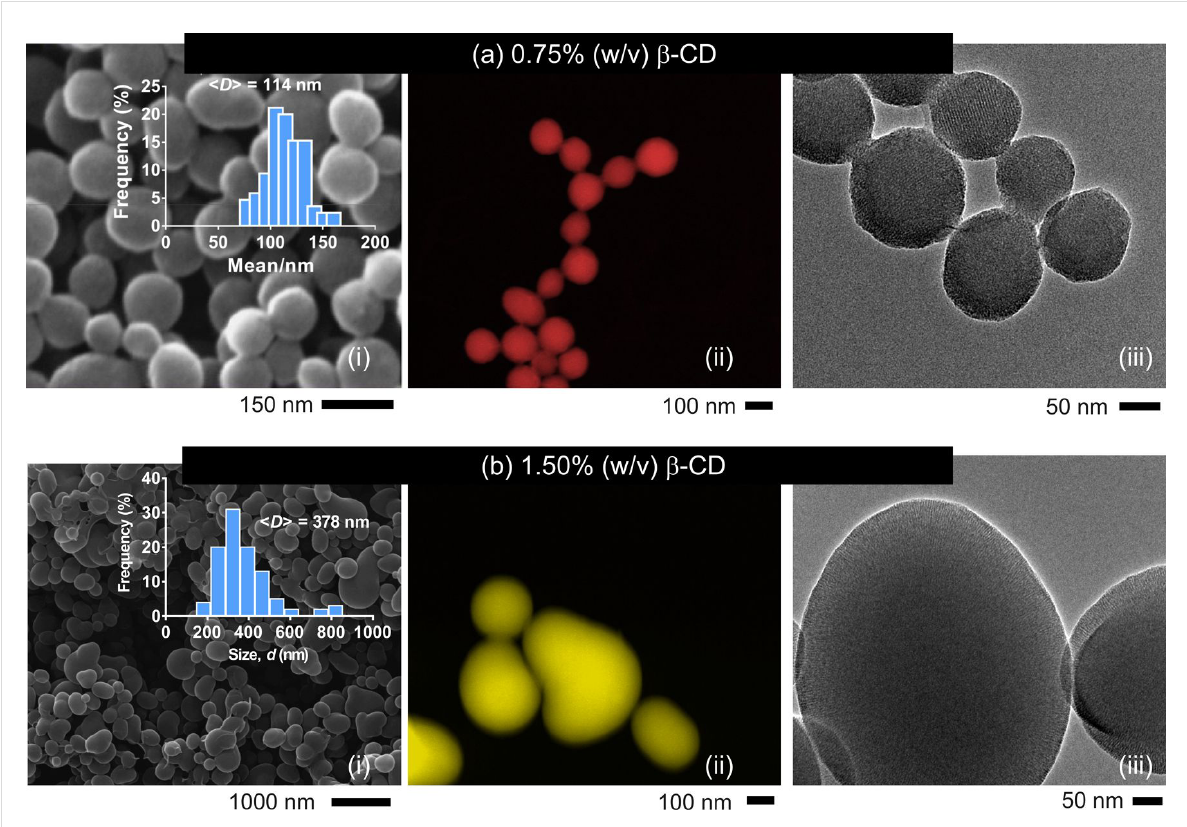
Figure 7: SEM (i), colored STEM (ii) and TEM (iii) images of MSNs produced at various β -CD contents; (a) MSN-14 ( c β -CD = 0.75% (w/v), r (CD/CTAC) = 3.75), and (b) MSN-15 ( c β -CD = 1.50% (w/v)), r (CD/CTAC) = 7.5). Insets (a(i), b(i)) show the size-distribution plots of the respective parti- cles.